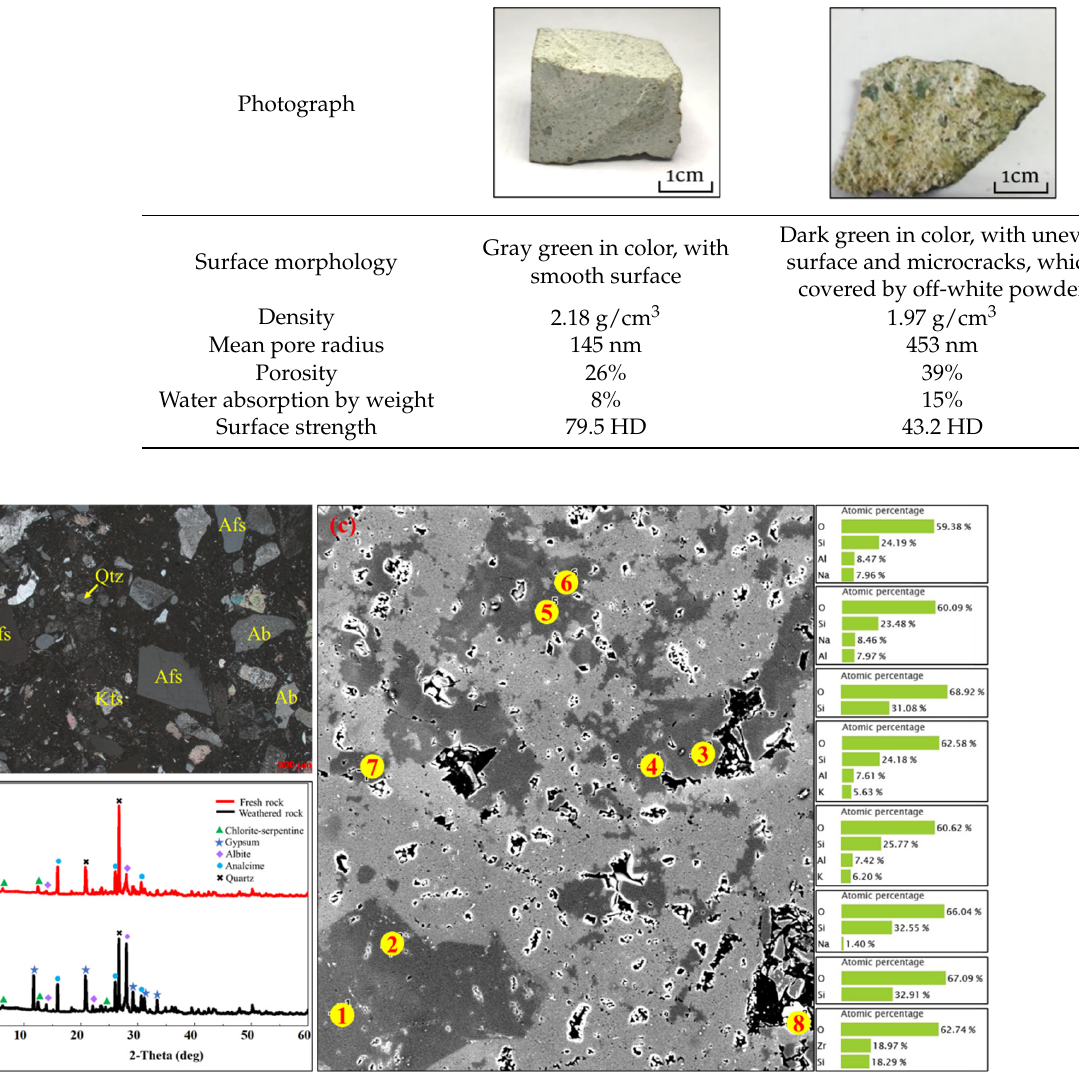
Figure 3. Mineralogical and petrographic properties rock sample from Sanlao stone house . ( a ) Po- larized optical microscopy photograph, Afs is Alkalifeldspar, Kfs is K-feldspar, Qtz is Quartz, Ab is Albite; ( b ) X-ray diffraction pattern of rock sample; ( c ) SEM-eds of rock sample, 1 to 8 are the eight points for energy spectrum.